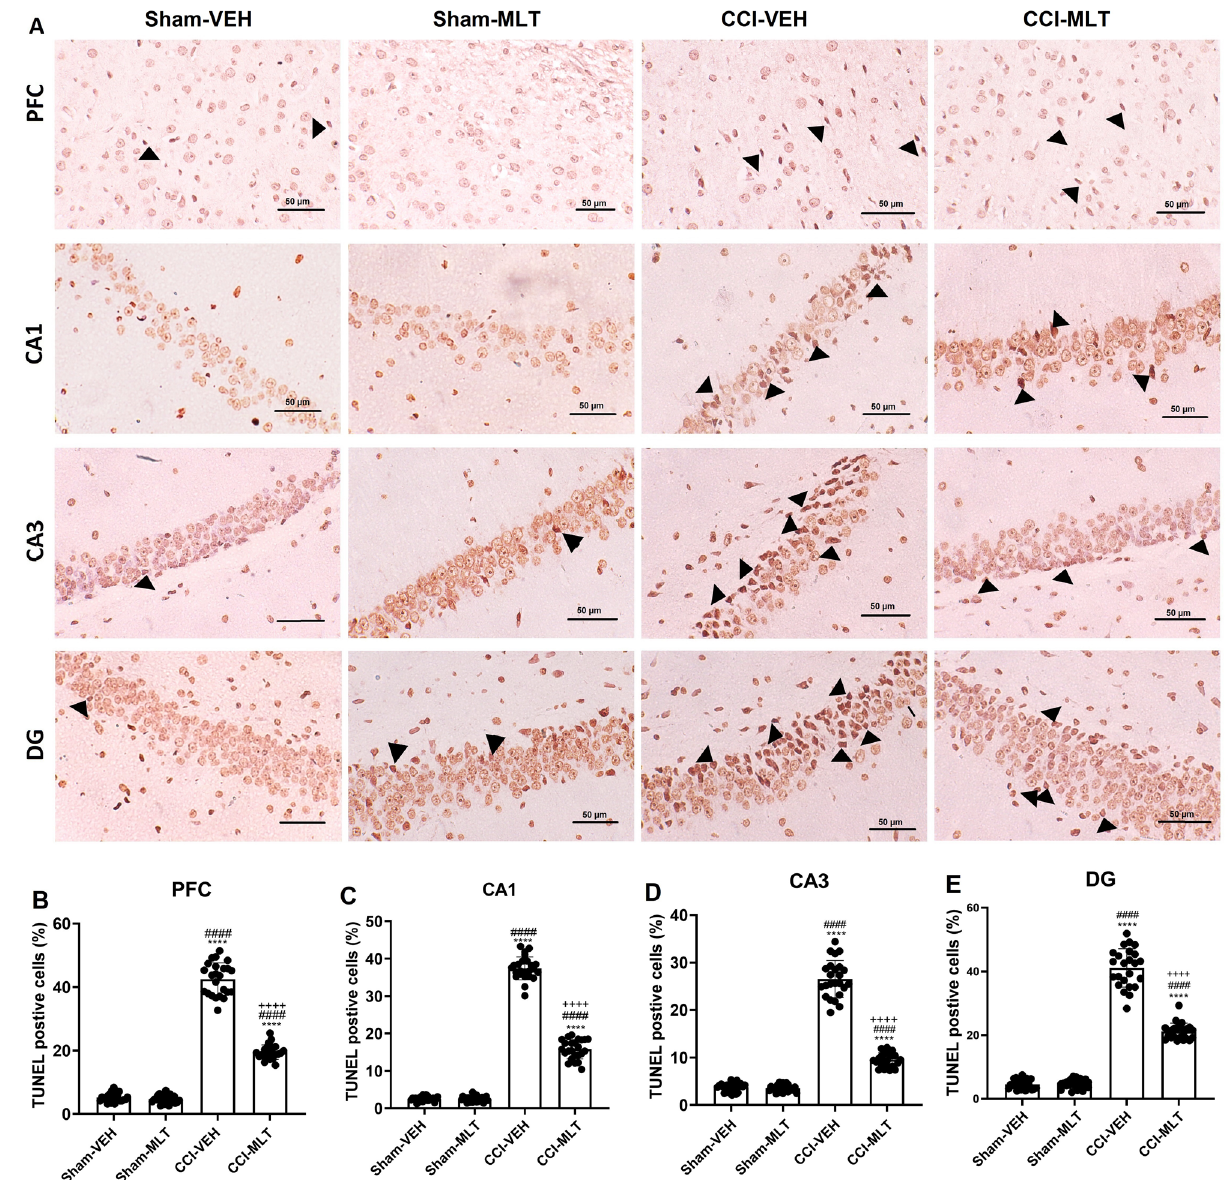
Figure 6. Effects of melatonin (MLT) on ( A ) the percentage of TUNEL-positive cells in the hippocampus and prefrontal cortex (PFC) of chronic constriction injury (CCI)-induced rats. Comparing the percentage of TUNEL + cells in the ( B ) PFC, ( C ) CA1, ( D ) CA3, and ( E ) DG among different groups. Arrows show TUNEL + cells with dark brown appearance (TUNEL staining, 100 ×). Percentage of TUNEL-positive cells **** P < 0.0001 compared with the Sham-VEH group; #### P < 0.0001 compared with the MLT group, and ++++ P < 0.0001 compared with the CCI-VEH group. Sham-VEH: sham-operated animals, Sham-MLT: sham- operated animals MLT (10 mg/kg), CCI-VEH: pain-induced animals, and CCI-MLT: pain-induced animals received MLT (10 mg/kg), mean ± standard deviation, n = 6 per